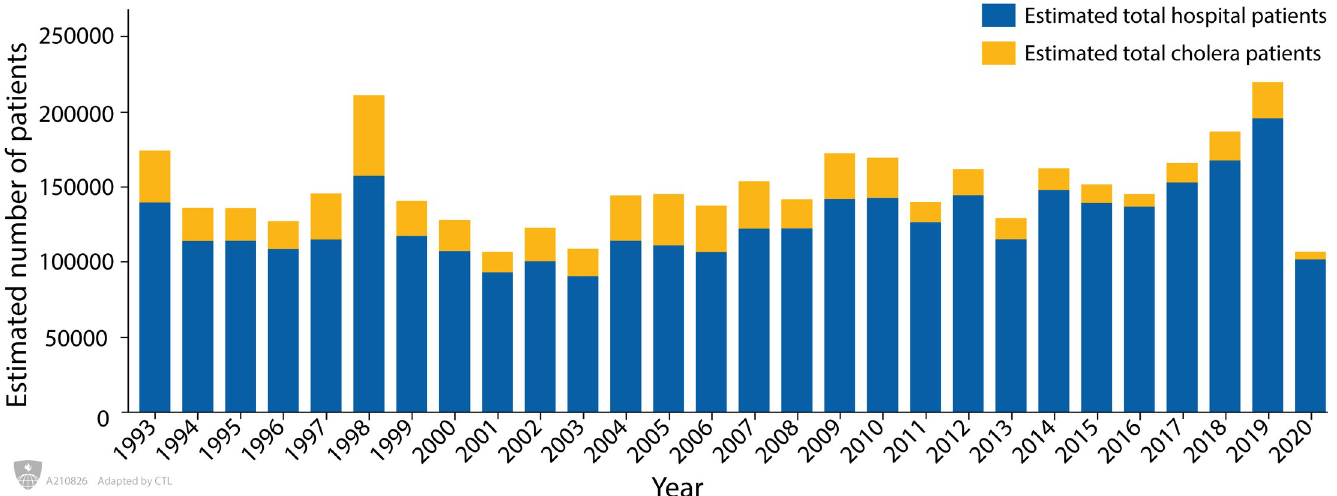
Fig 2. Yearly total number of estimated hospital patients and the total number of estimated cholera patients attended to the Dhaka Hospital of icddr,b; Bangladesh (1993–2020).